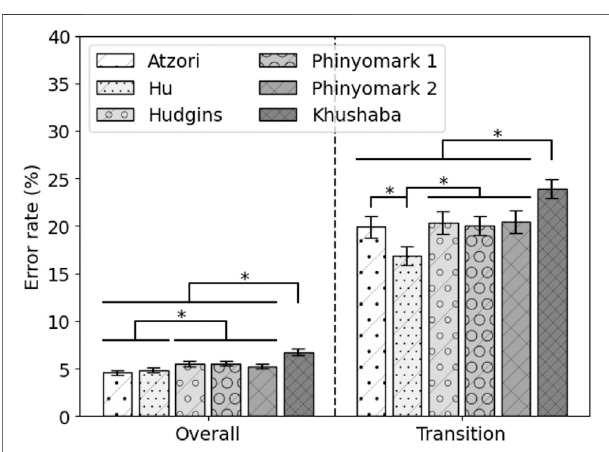
FIGURE 4 | Average error rate ( ± SEM) of the state-of-the-art feature sets on80% oftheMyPredict dataset. Astarindicates asigni fi